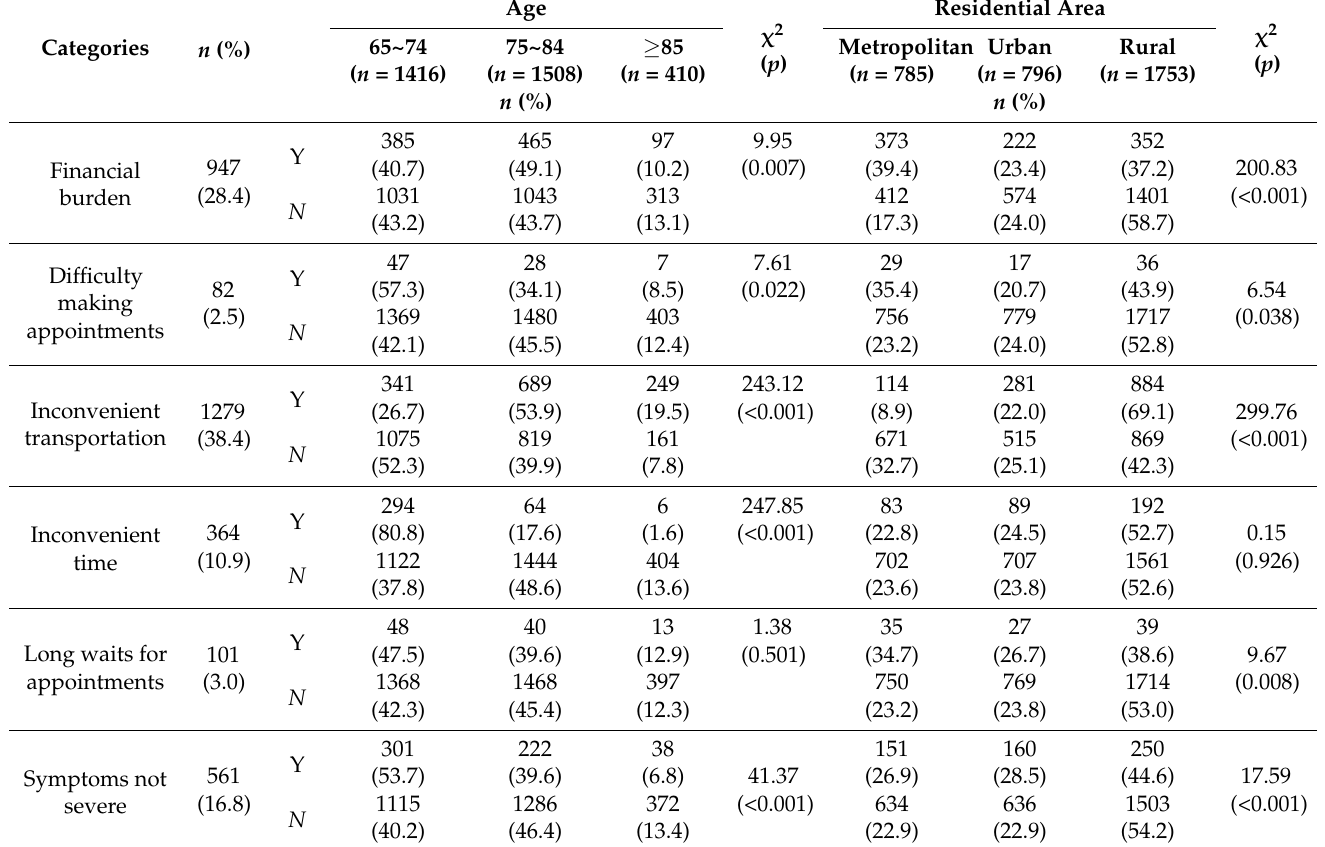
Table 2. Differences in reasons for unmet healthcare needs according to age and residential